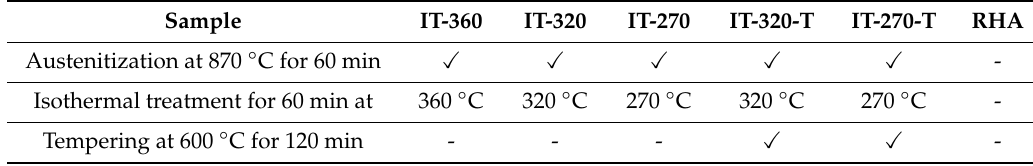
Table 2. Heat treatment conditions applied to the RHA plates.